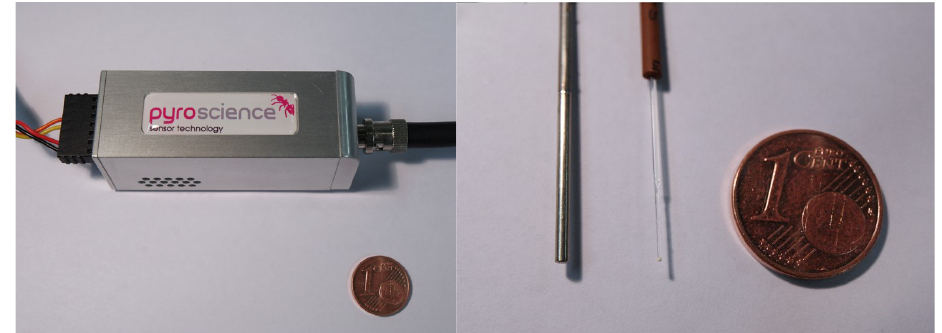
Figure 2. Left: Photographic images of the compact phase fluorometer from PyroScience. Right: from left to right: photographic image of resistance thermometer PT-100, fiber optic temperature microsensor and 1 euro cent for size